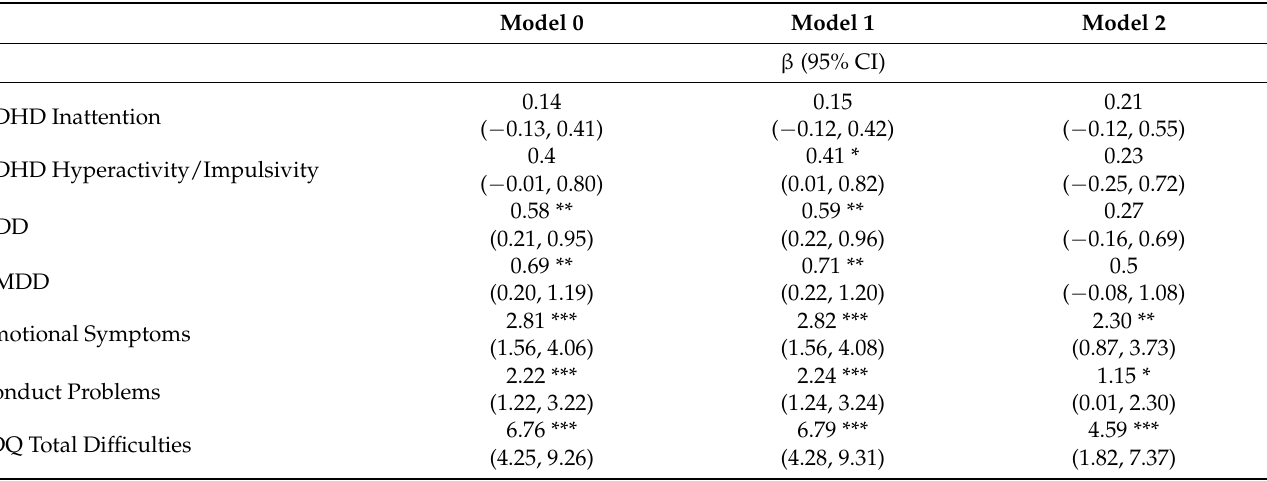
Table 4. The associations of food security status with attention deficit hyperactivity disorder and mood dysregulation